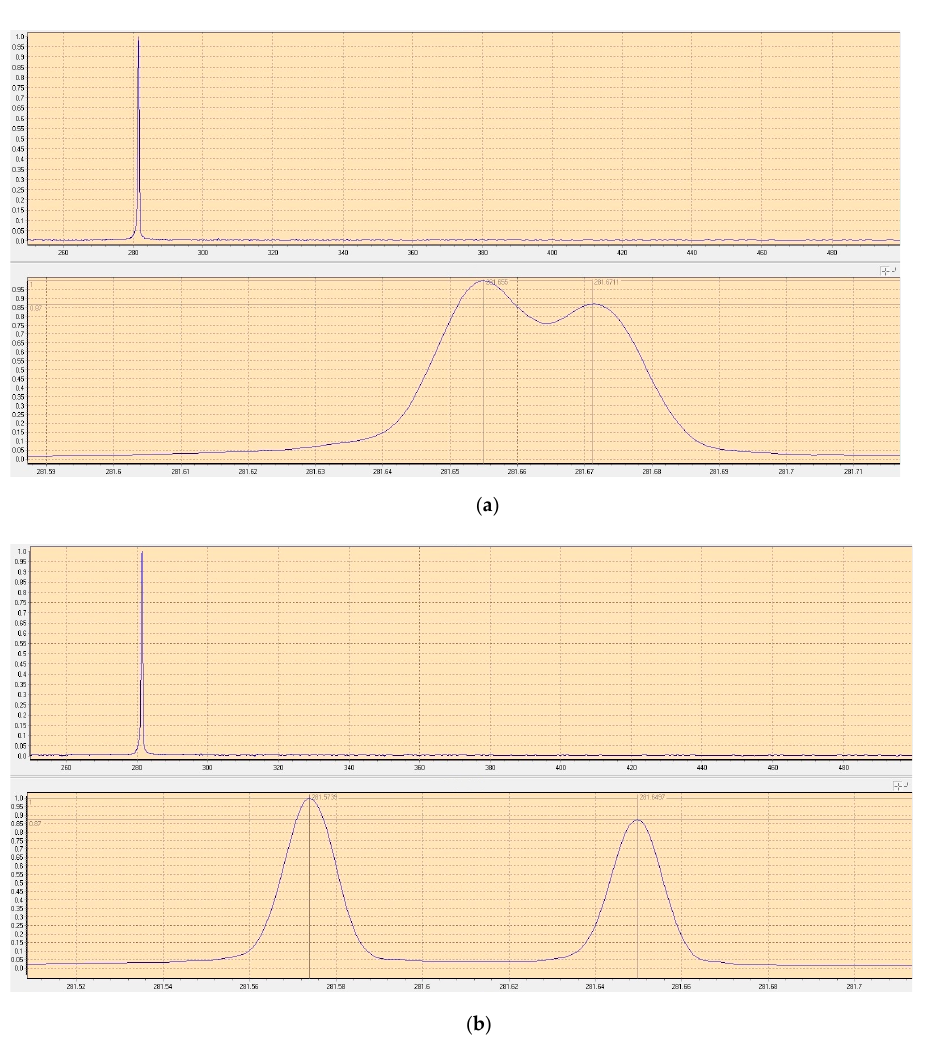
Figure 36. Oscillating spectrum of dual-frequency laser with different frequency differences of ( a ) 16 GHz and ( b ) 76 GHz